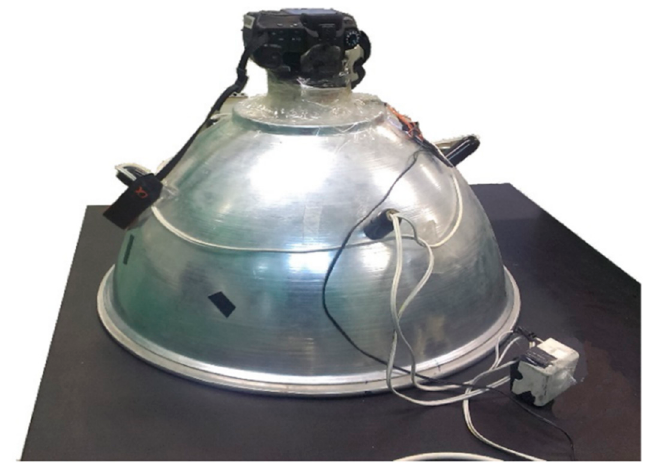
Figure 1. View of the imaging system.